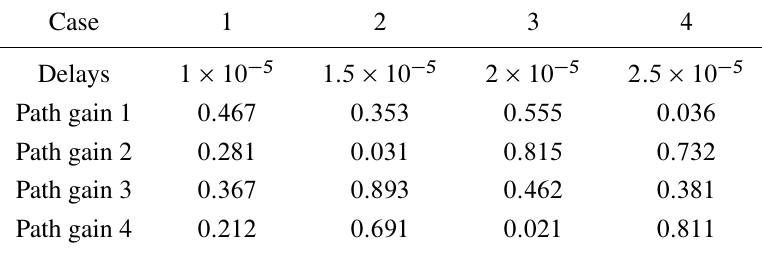
Table 4. Truncated data set used to generate significant and CCI channel components for four different delays and frequency selective paths of a Rayleigh faded channel.